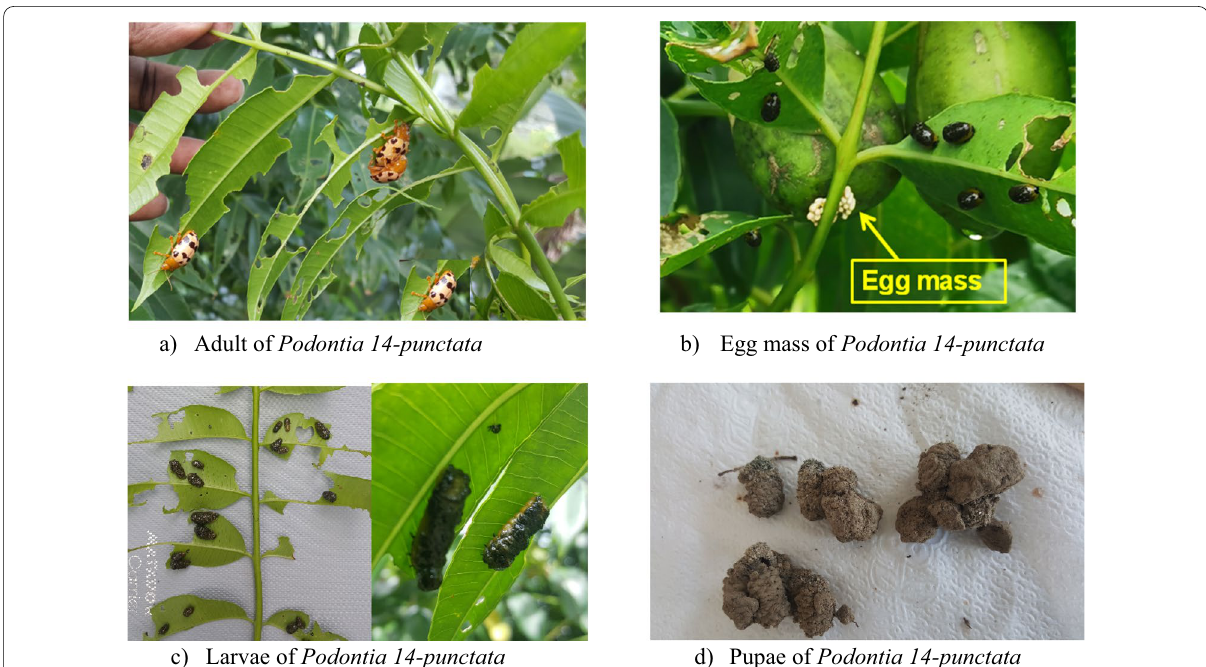
Fig. 1 Different growth stages of hog plum ( amra ) leaf beetle, Podontia